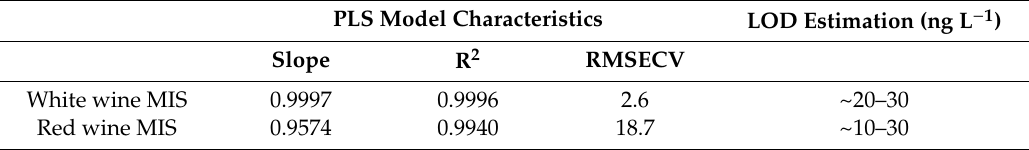
Figure 7. ( A ) Score plot with the first and second PLS components of the PLS regression analysis of iprodione in white wine with the MIS sensor. Iprodione concentrations varied between 0 and 250 ng L − 1 . ( B ) Regression coe ffi cients versus frequency for iprodione in white wine with the MIS sensor (on factor 6). ( C ) Observed and predicted values of iprodione concentrations in white wine using six factors. Coe ffi cient of determination R C2 for the calibration (blue) and R V2 for the validation (red) datasets, root mean squared errors (RMSEC for the calibration set and RMSEV for the validation set). Iprodione concentrations varied between 0 and 250 ng L − 1 . Table 1. PLS results and estimation of LOD for iprodione using the MIS sensor in white and red